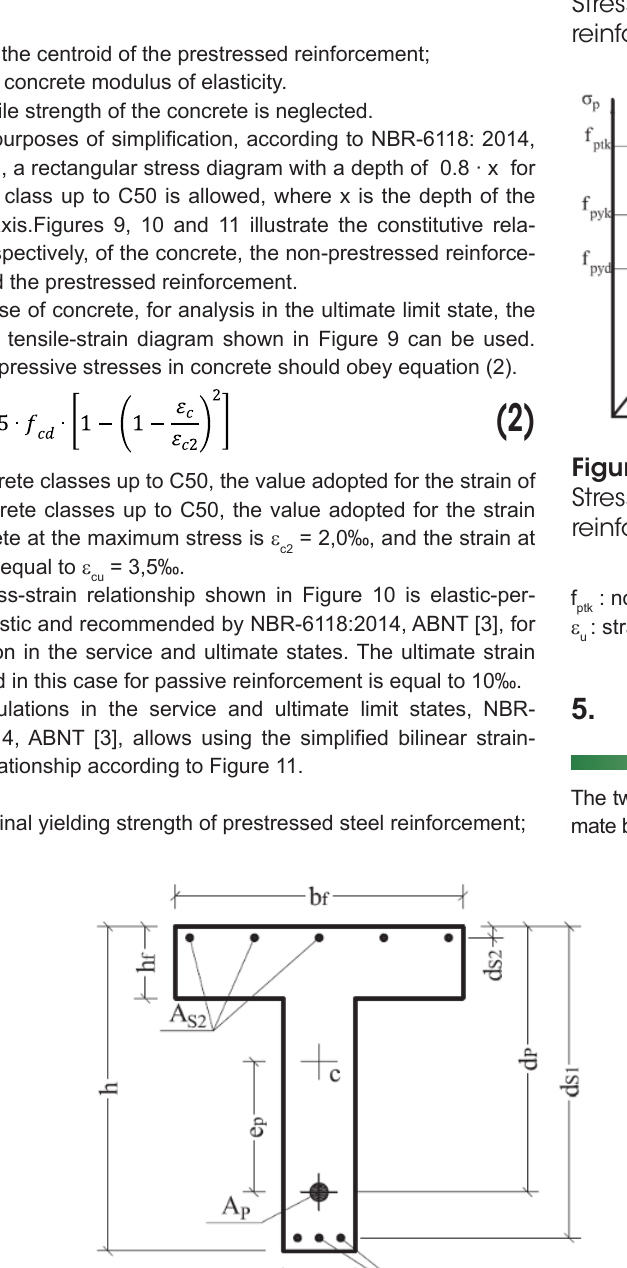
Stress-strain relationship for concrete in compression